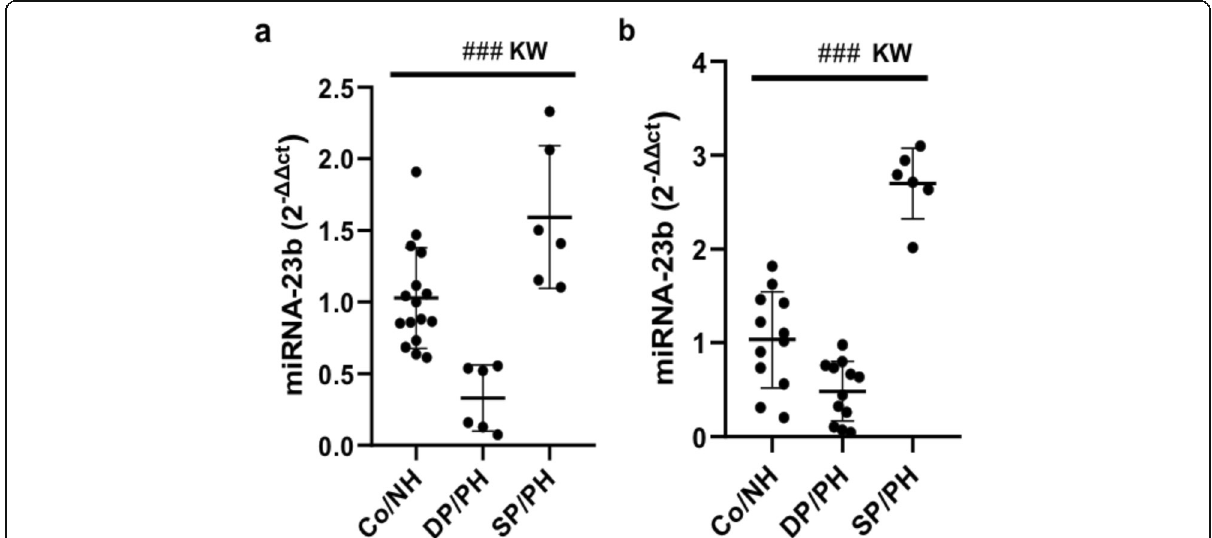
Fig. 1 Changes in the miRNA-23b expression levels in early onset sepsis. Scatter plot values a on the left represent the miR-23b level for EOS in the at-term newborns, measured by (2 - ΔΔ CT ). While that scatter plot in b on the right represent the miR-23b level in the premature newborns. The line inside the boxes corresponds to the median values. For the at-term patients, Co/NH ( n = 9), DP/PH ( n = 2), SP/PH ( n = 7). For the premature patients, Co/NH ( n = 4), DP/PH ( n = 3), SP/PH ( n = 2). Co/NH: negative haemoculture, DP/PH: positive haemoculture in dead newborns, SP/PH: positive haemoculture in the newborns who survived. KW: Kruskal-Wallis. The sharp indicate significant differences highlighted between all groups using the Kruskal-Wallis test: ### p < 0.001